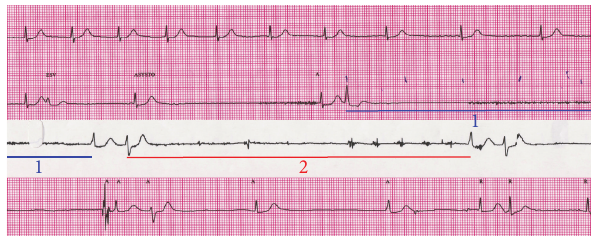
Figure 1: Continuous electrocardiographic recording of lead 1 at a speed of 25 mm/s showing progressive bradycardia leading to two episodes (1 and 2) of asystole both lasting 5.9 seconds, followed by a progressivereturntosinusrhythm.Onthesecondline,thefirstwave shows a premature atrial contraction while the third wave shows a premature junctional complex. On the third line, cardiac massage is noted. On the fourth line, the fourth wave is showing fusion of the P and QRS